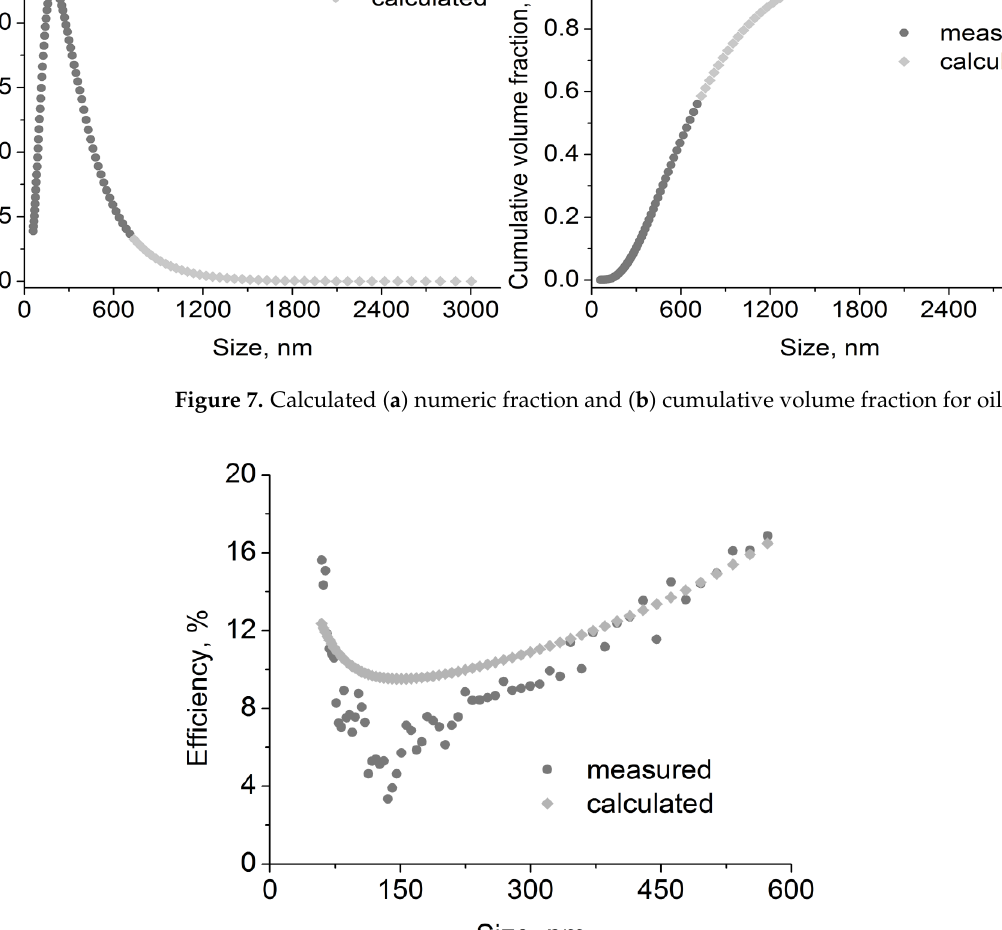
Figure 7. Calculated ( a ) numeric fraction and ( b ) cumulative volume fraction for oil aerosol.